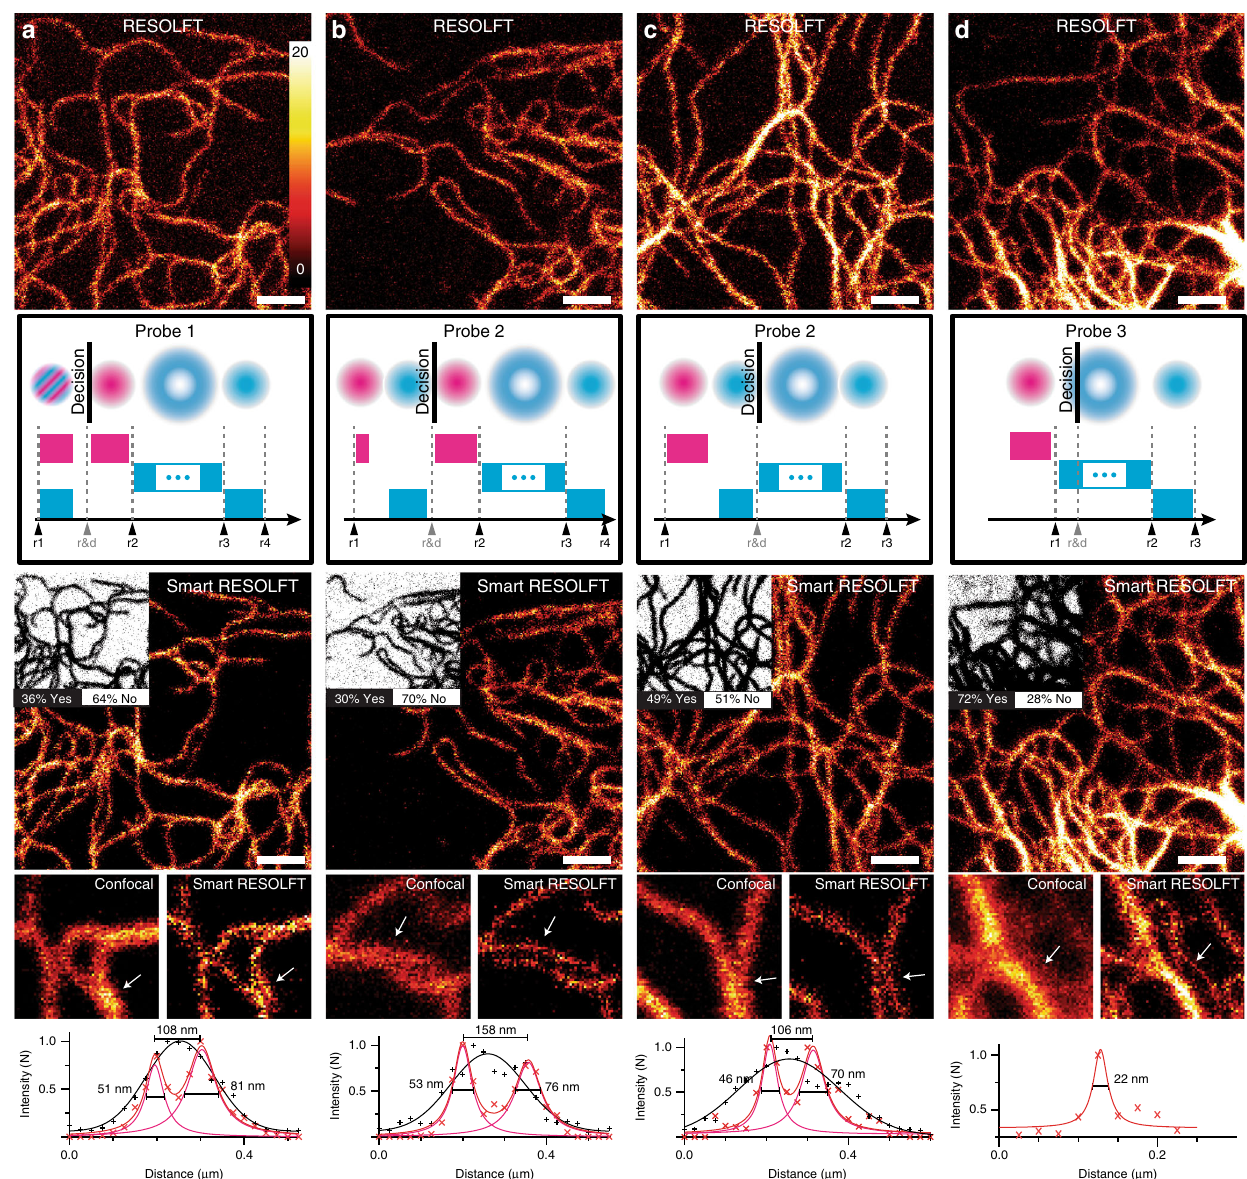
Fig. 2 Probe types and decision-making in smart RESOLFT imaging. a − d In the top row conventional RESOLFT images of vimentin-rsEGFP2 are shown. By applying the smart RESOLFT illumination schemes illustrated below each image, we acquired a second image in the smart RESOLFT mode. The insets in the smart RESOLFT images represent the decision map containing the skipped pixels (white, NO), and the ones that undergo the full pulsing scheme (black, YES). For each smart RESOLFT image we provide a zoom of a small region, the related confocal image and a line pro fi le (white arrow) for comparison. Each line pro fi le is averaged across three pixels, and the full-width at half-maximum and peak-to-peak distance of Lorentzian fi ts is shown in the line pro fi le. Scale bars are 1 µ m, the zoom region is 1.5 by 1.5 µ m 2 . RESOLFT REversible Saturable/Switchable Optical Linear Fluorescence